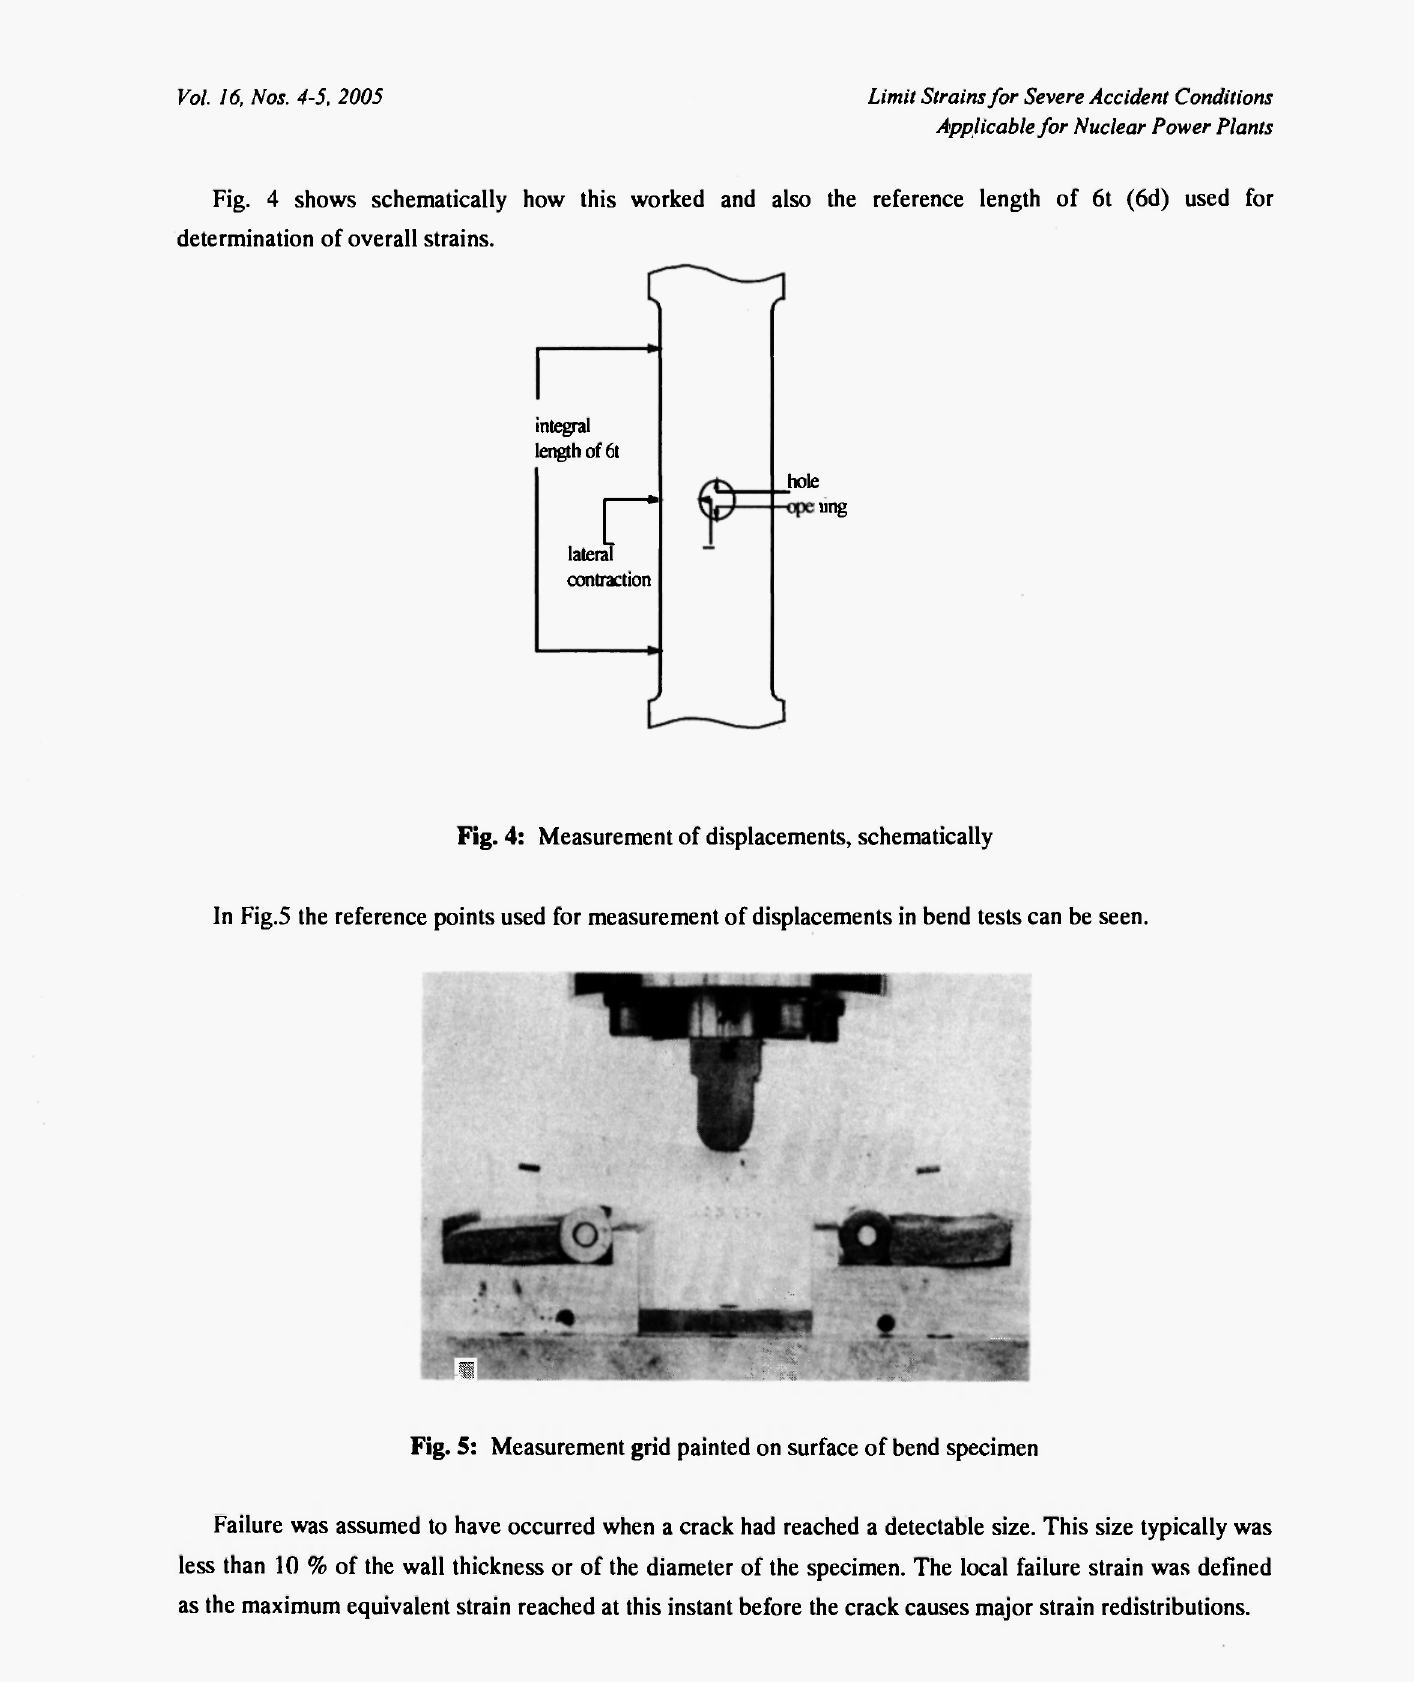
Fig. 5: Measurement grid painted on surface of bend